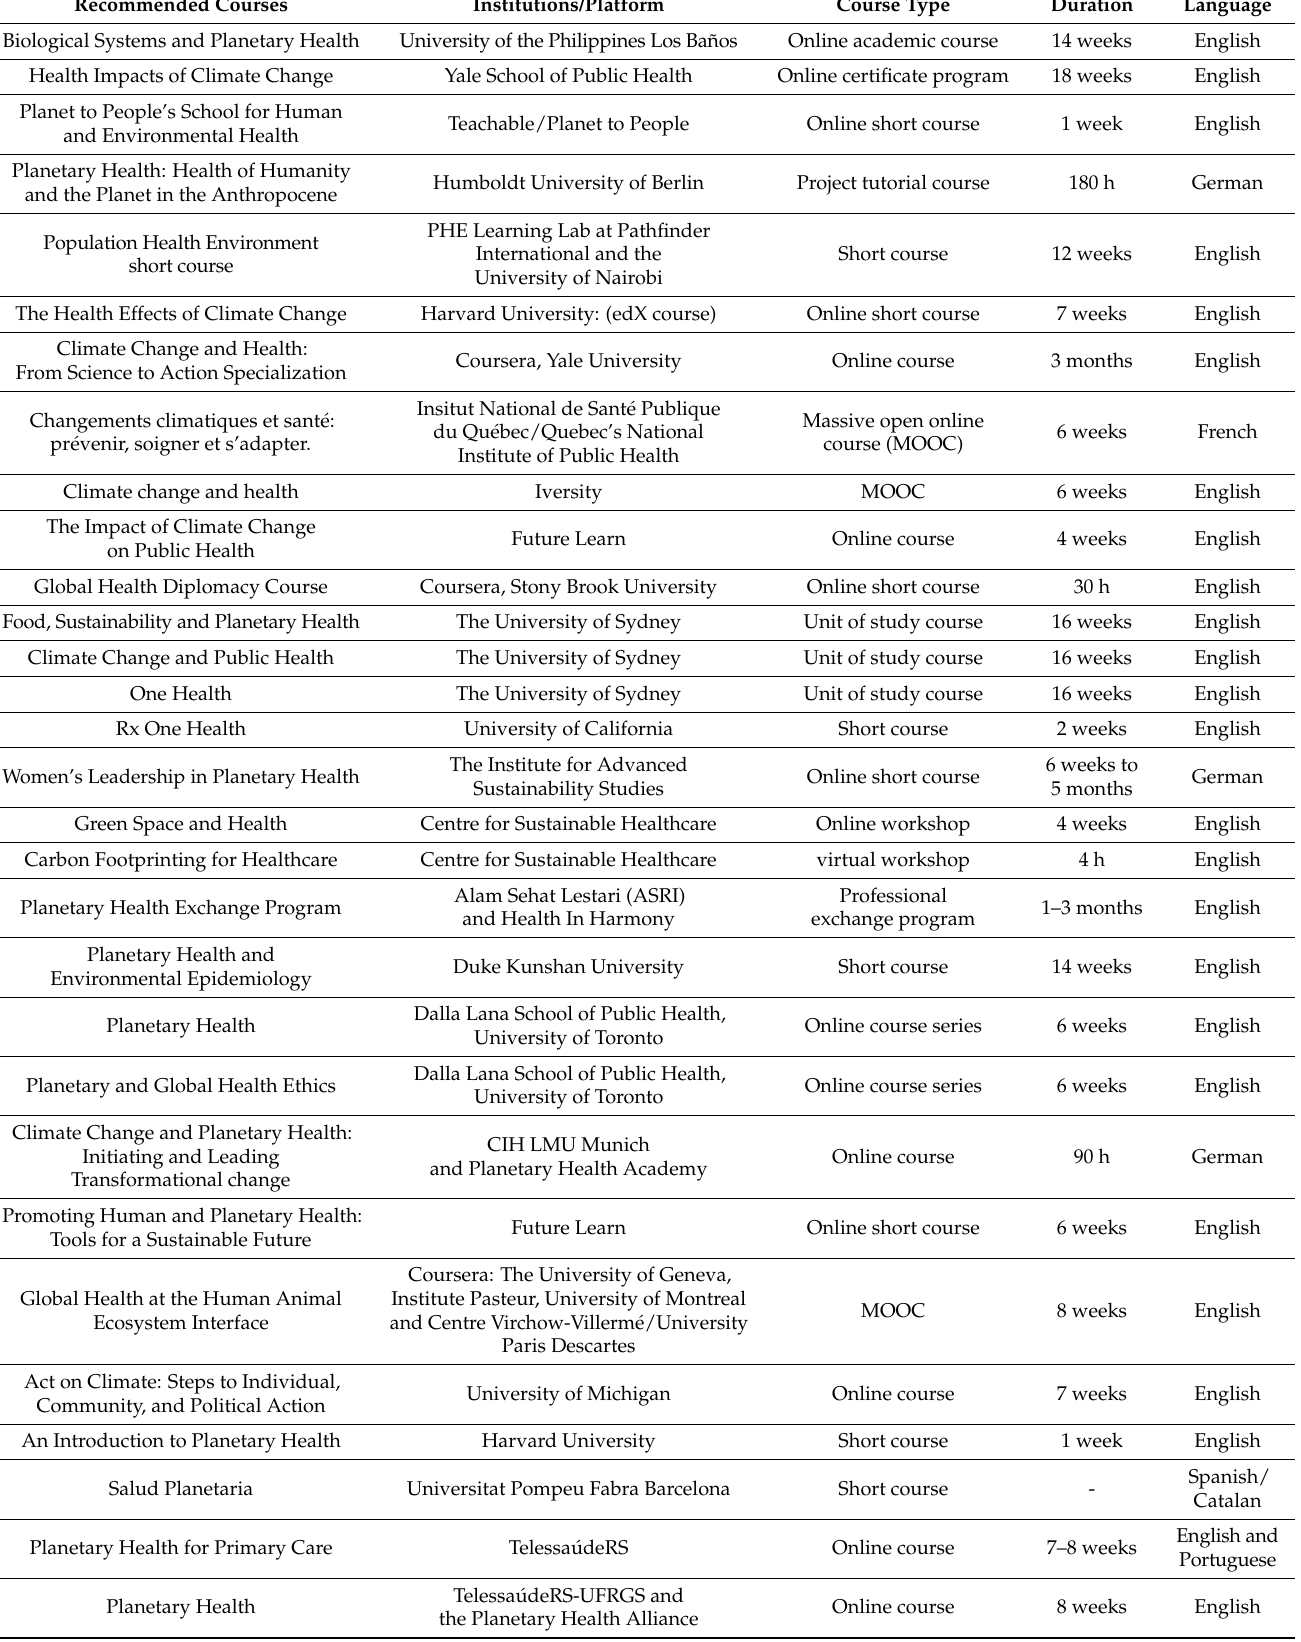
Table 1. Available short courses for planetary health